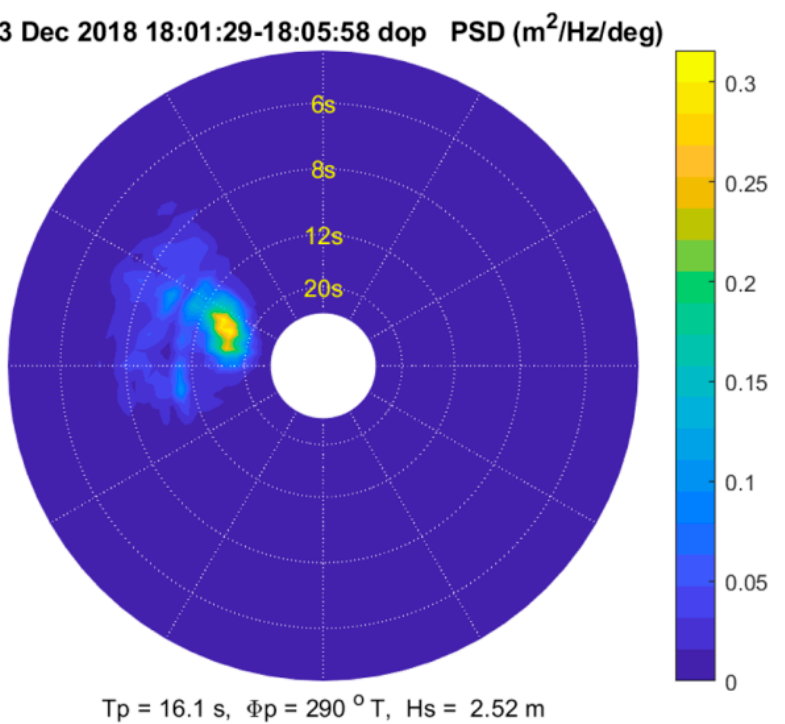
Figure 1. Directional wave spectrum computed from Doppler radar data.